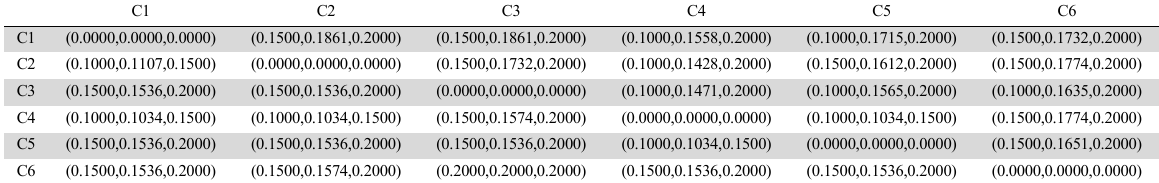
Normalized Matrix